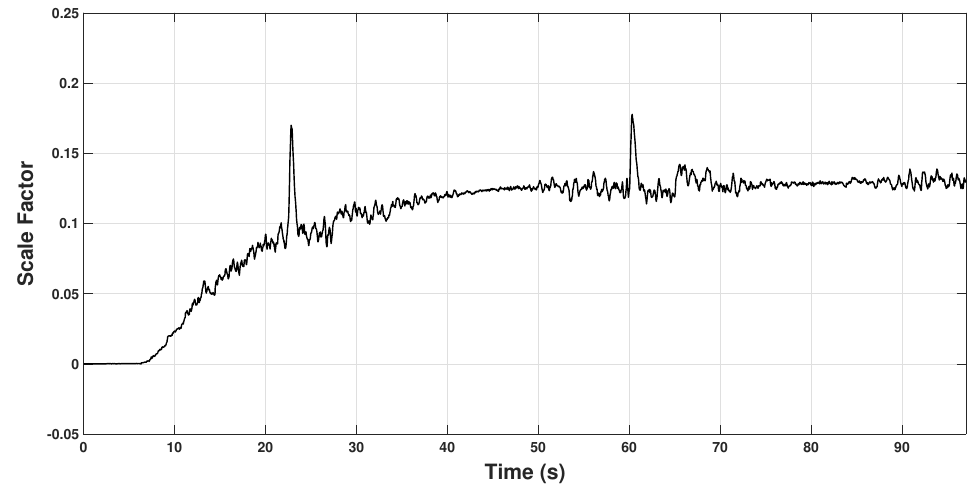
Figure 9. Estimated scale factor β 2 y on the Y i axis.